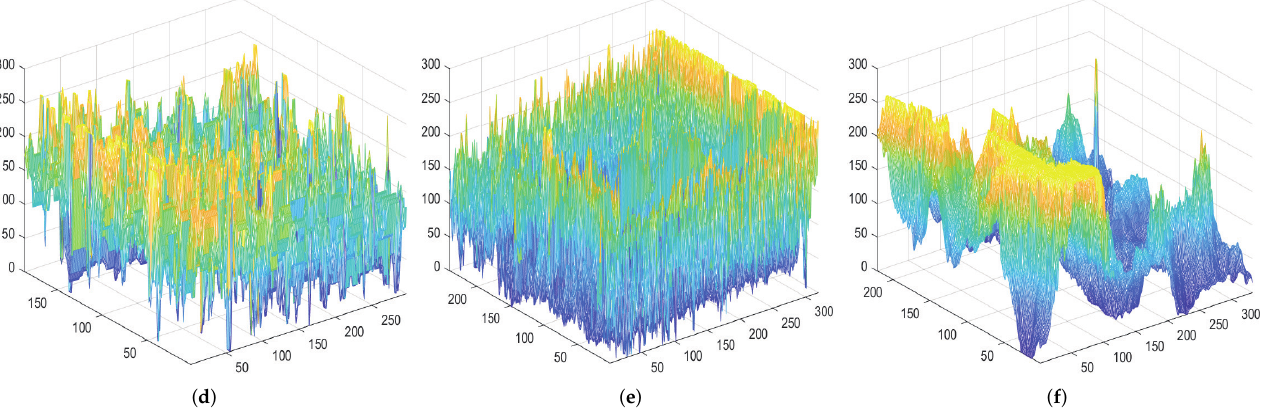
Figure 7. Infrared images of some real scenes. ( a ) Scene 1 (Seq1). ( b ) Scene 2 (Seq2). ( c ) Scene 3 (Seq3). ( d ) Scene 4 (Seq4). ( e ) Scene 5 (Seq5). ( f ) Scene 6 (Seq6).